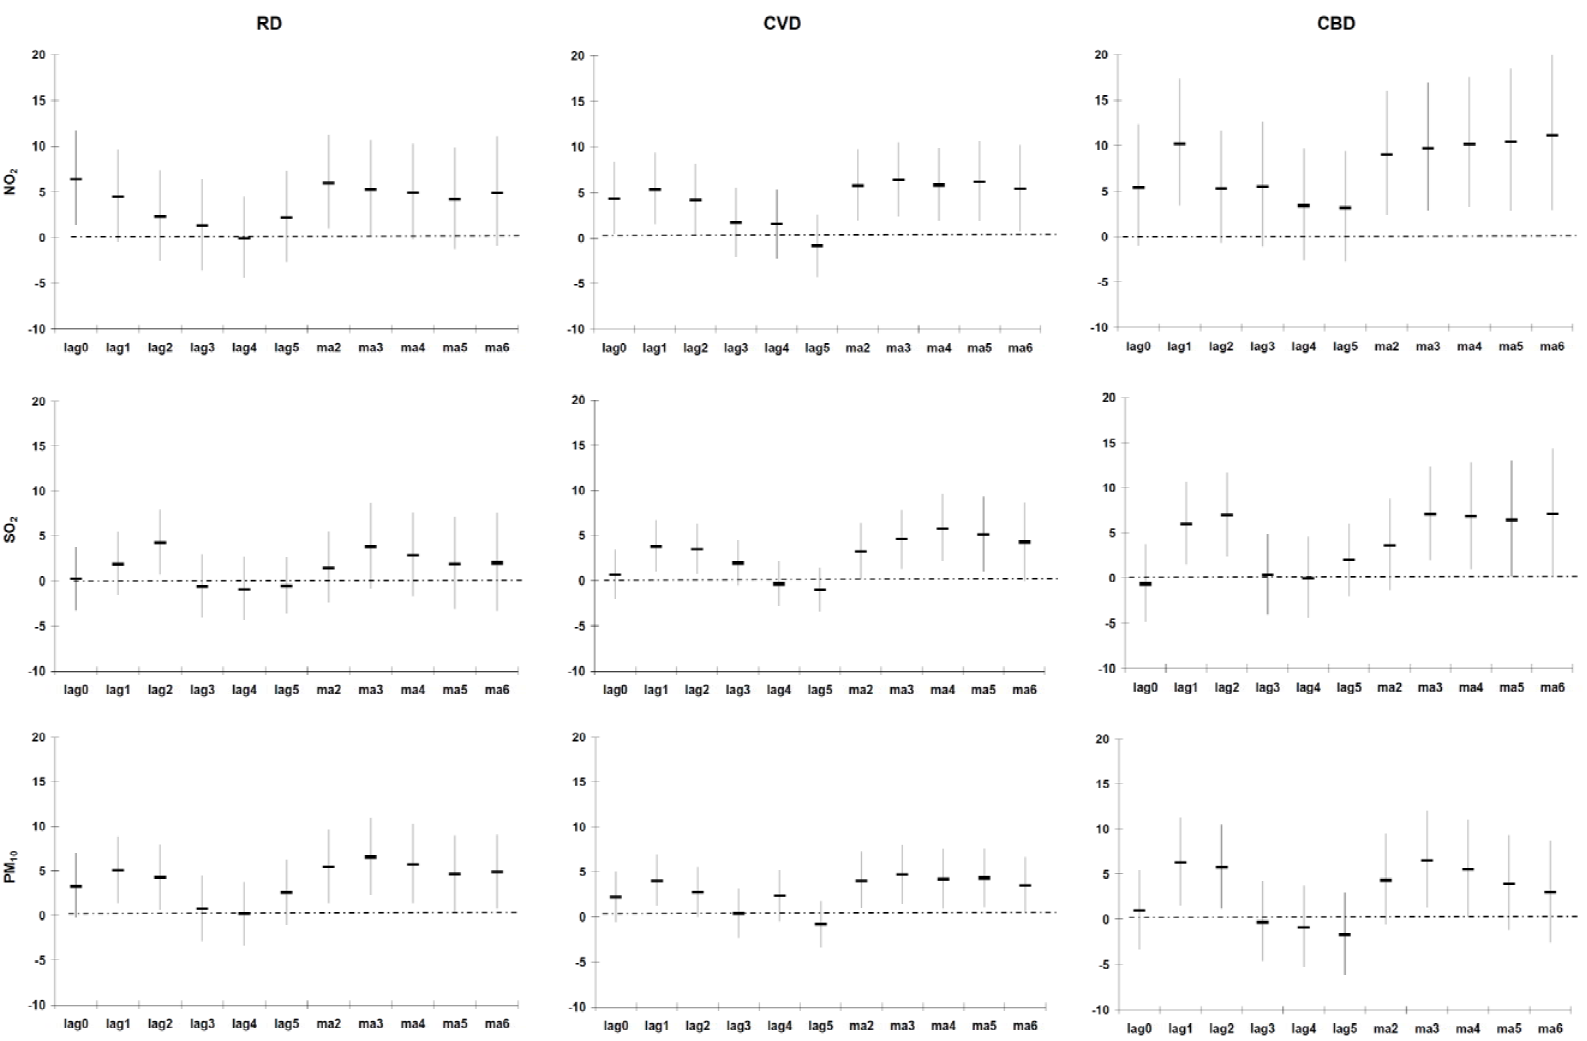
, NO and SO 10 2 2